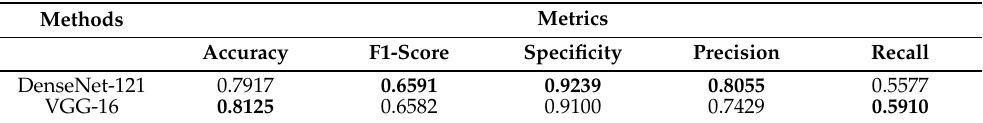
Table 4. Performance of the pretrained networks DenseNet-121 and VGG-16 considering the test sets for the classification scenario of 724 images (without lesions and with lesions larger than 2.0 mm) from the UFPE database. The best values are presented in bold.